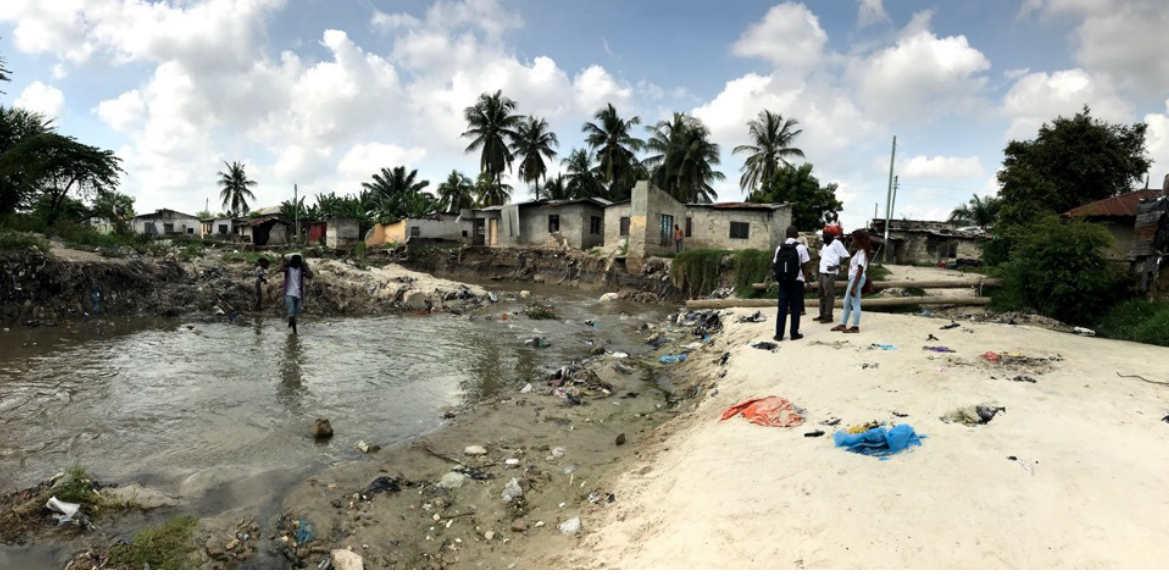
Figure 11. The former